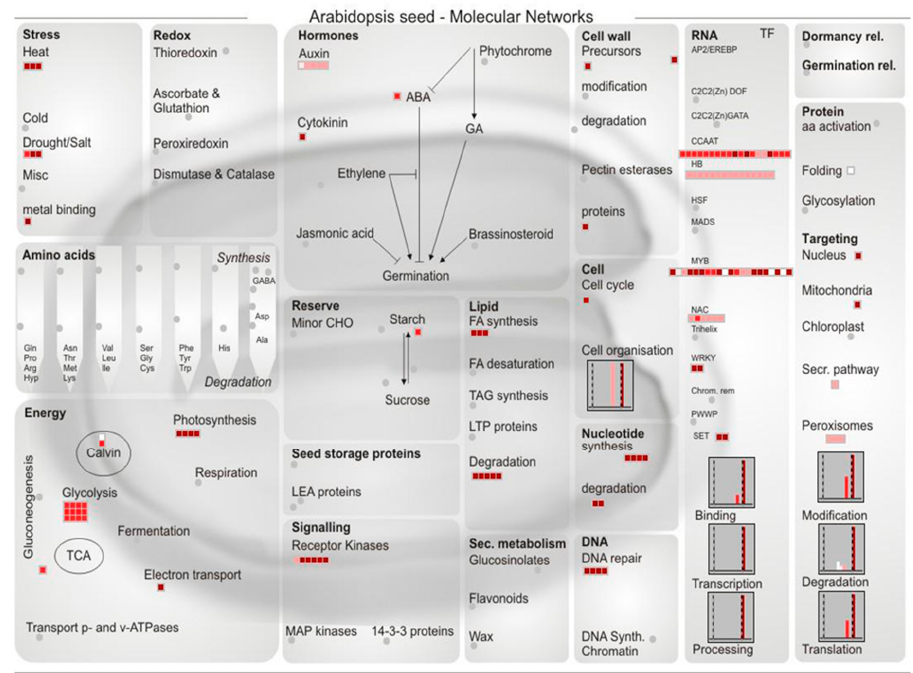
Figure 2. Global view of metabolic pathway-embedded targets the predicted cleavable targets of maize xylem miRNAs.